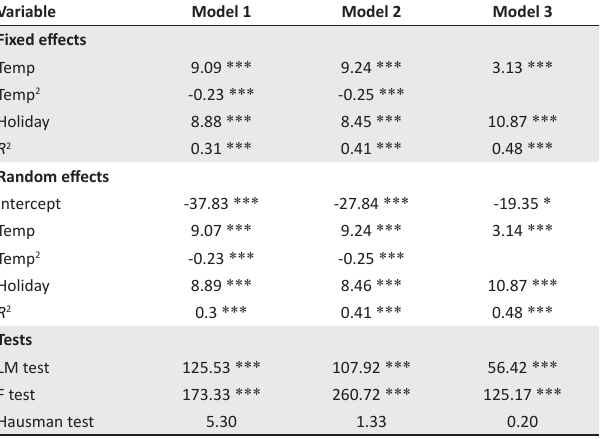
TABLE 3: Results of the fixed effects and random effects panel regressions and the results of the Lagrange Multiplier Test for balanced panels, the F test for individual effects and the Hausman Test.